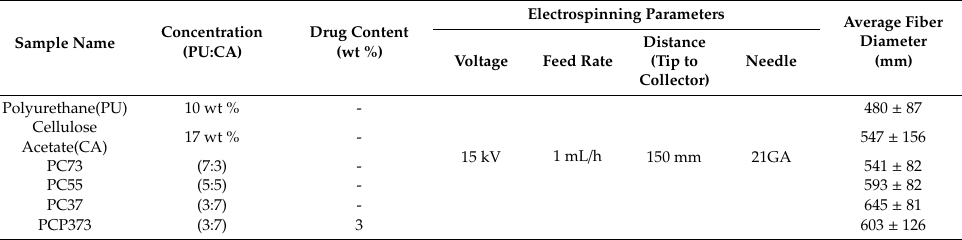
Table 1. Electrospinning parameters and nanofiber